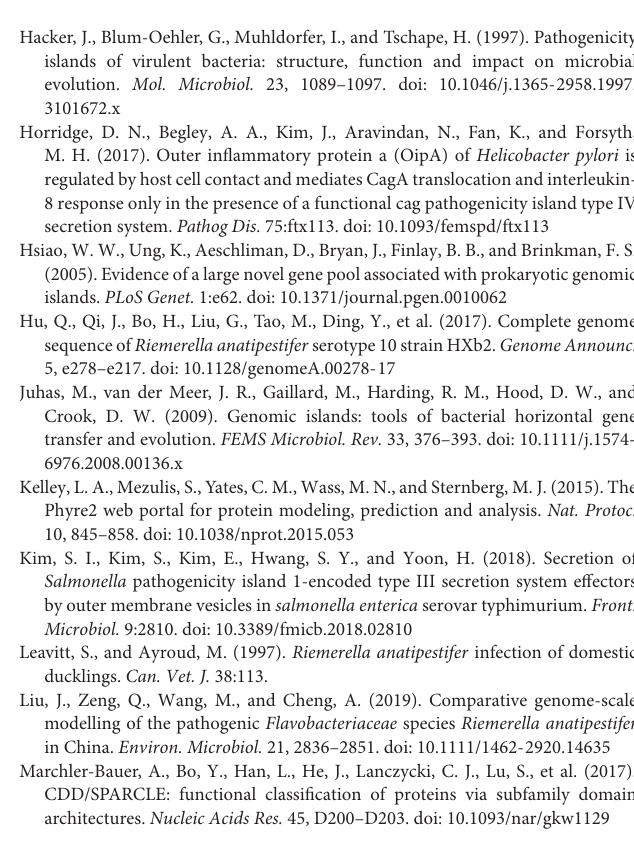
FIGURE S1 | Twenty 10K GI sequences were compared and the phylogenetic tree was constructed. FIGURE S2 | The conserved integrase amino acid sequence alignment results. TABLE S1 | Riemerella anatipestifer ATCC 11845 10K GI ORFs list. TABLE S2 | 10K GI in twenty Riemerella anatipestifer